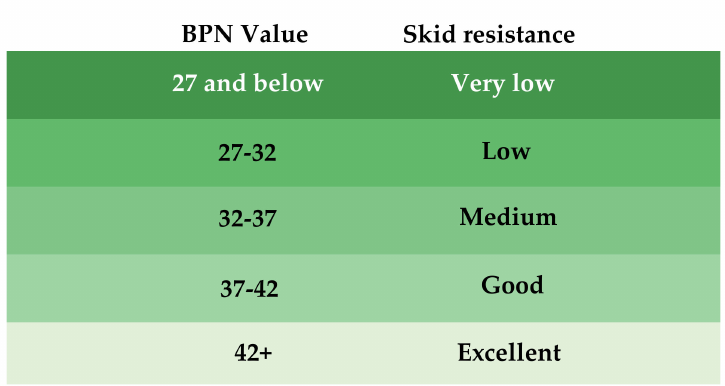
Figure 5. Relationship between BPN and skid resistance on